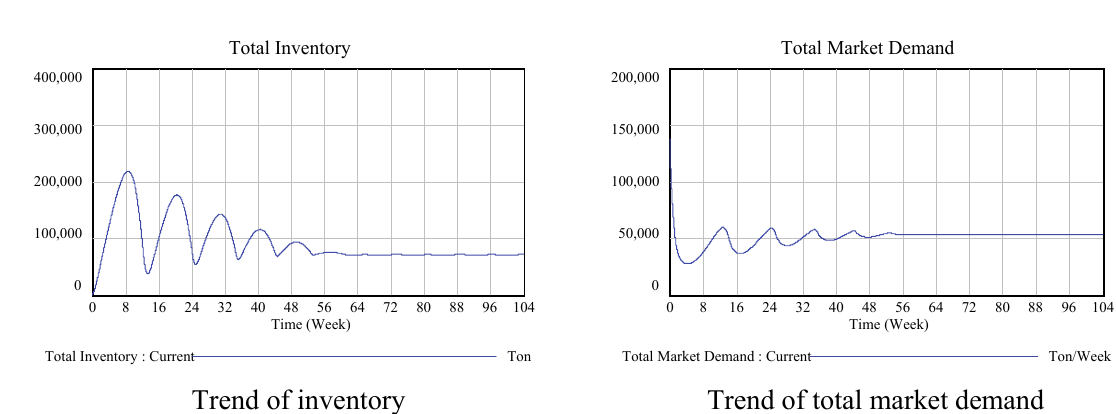
Fig. 9. The trend on inventory and market